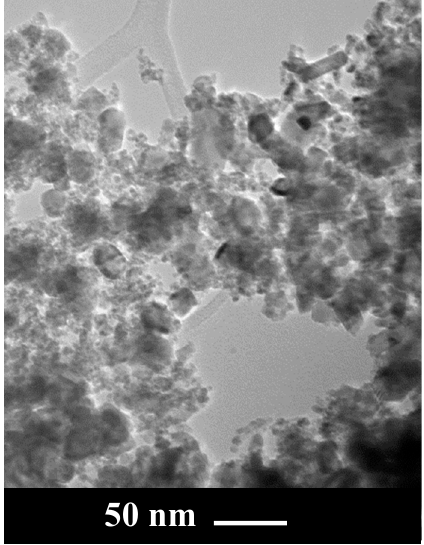
Figure 1. TEM image of RuO 2 .